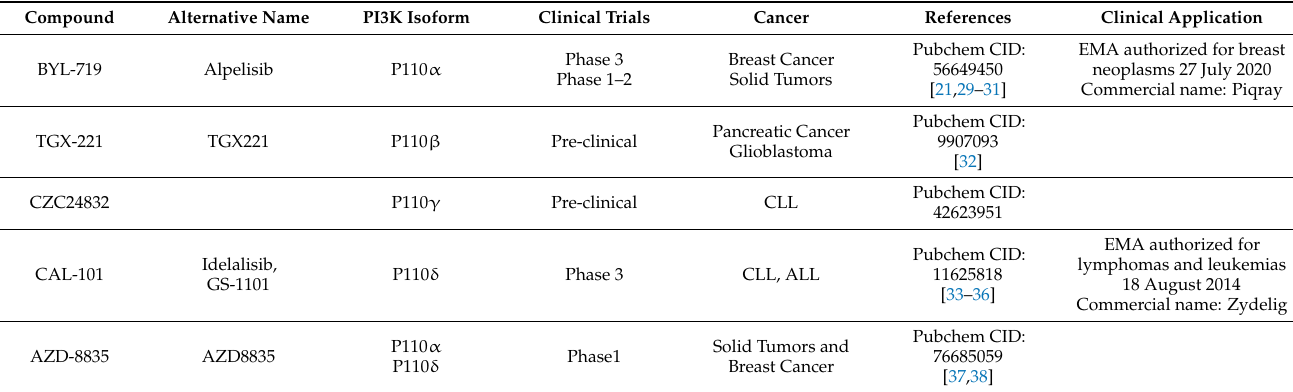
Table 1. PI3K inhibitors used in this